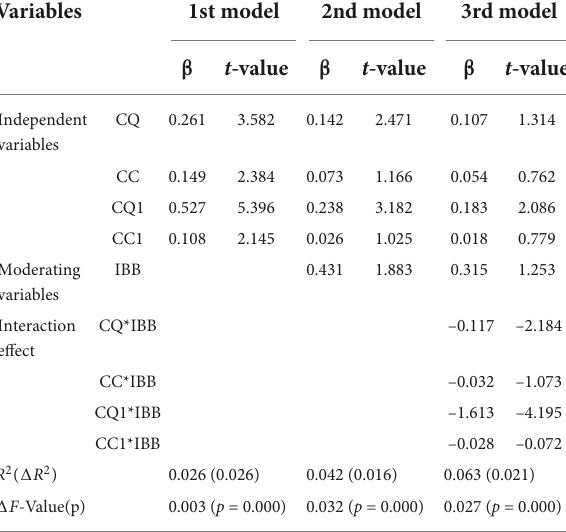
TABLE 7 Test results of moderating effect of fashion